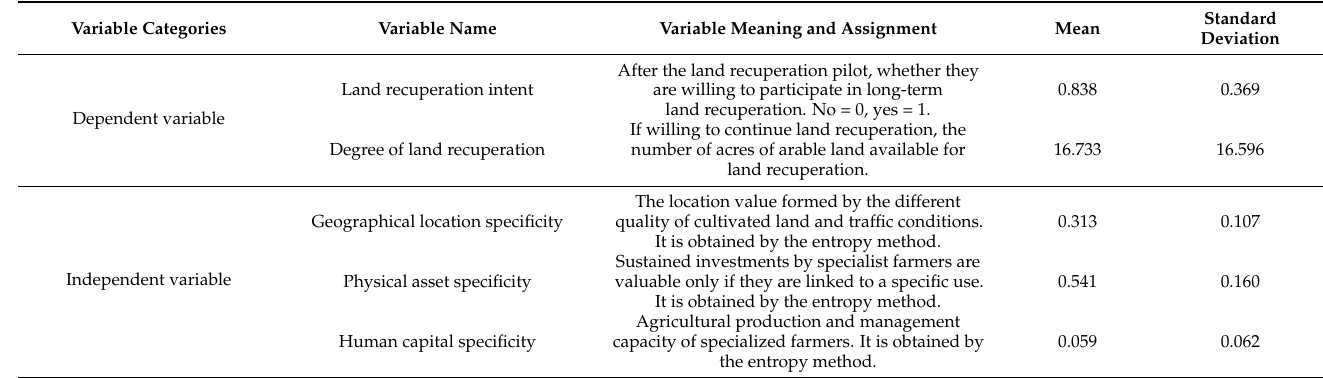
Table 2. Variable meanings and descriptive